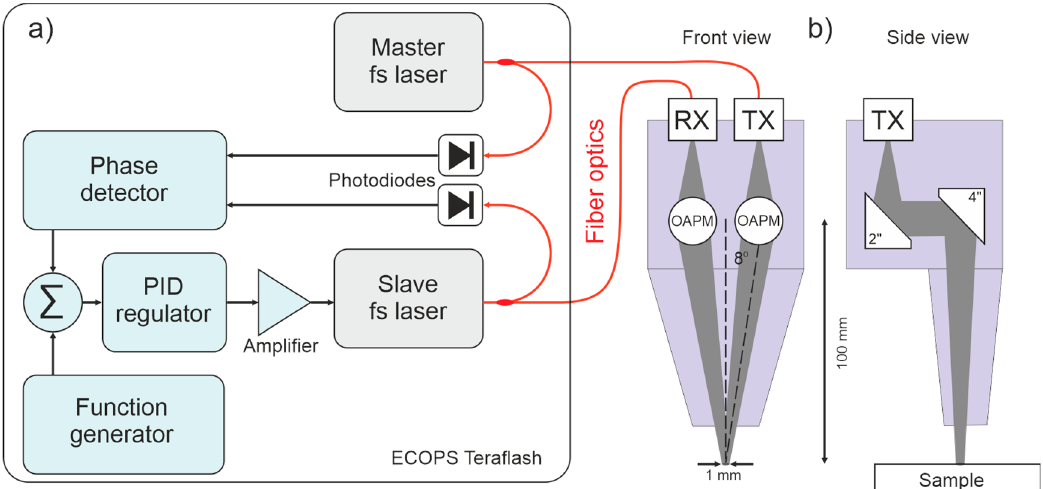
Figure 1. Scheme of Toptica TERAFLASH platform ( a ) and the reflection THz head ( b ) (based on 17).